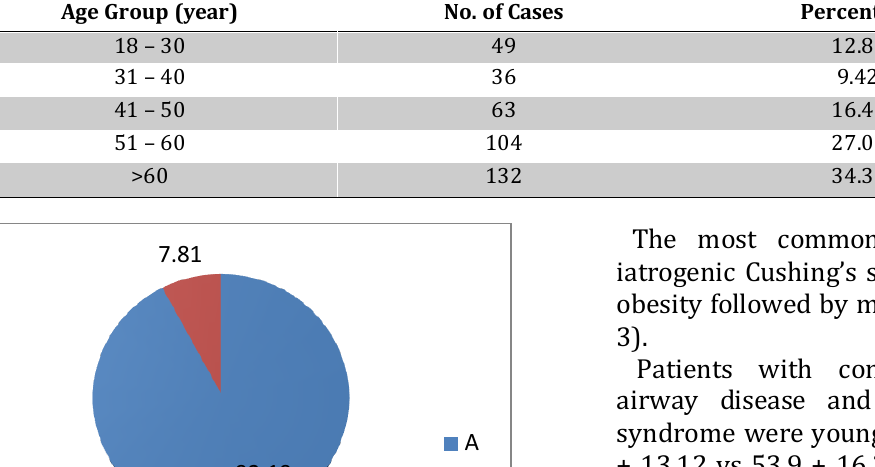
Table-2 . Age wise distribution of the cases (n=384)